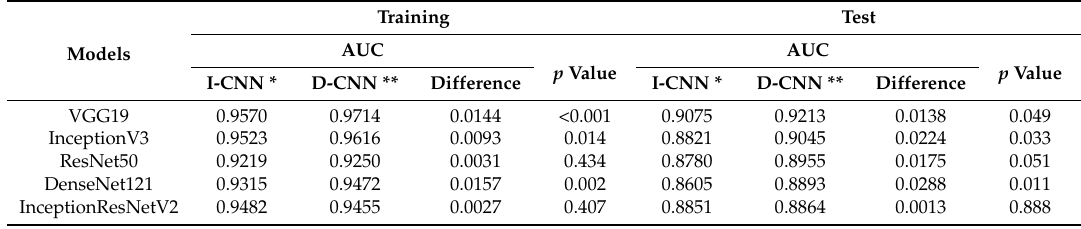
Table 2. Comparison of the area under the curve (AUC) when using only images and when adding demographic